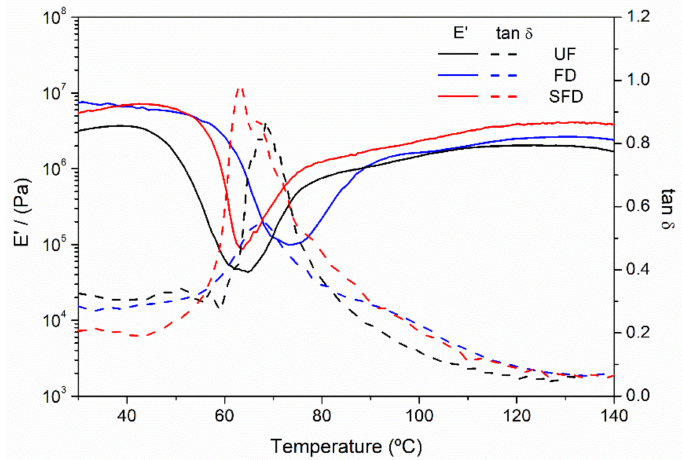
Figure 2. Evolution of the compressional storage modulus (E (cid:48) ) and loss tangent (tan δ ) of blends from porcine plasma protein (PPP) and glycerol materials using UF, FD, and SFD protein systems, obtained through temperature sweep tests ranging from 30 to 140 ◦ C at 1 Hz within the lineal viscoelastic